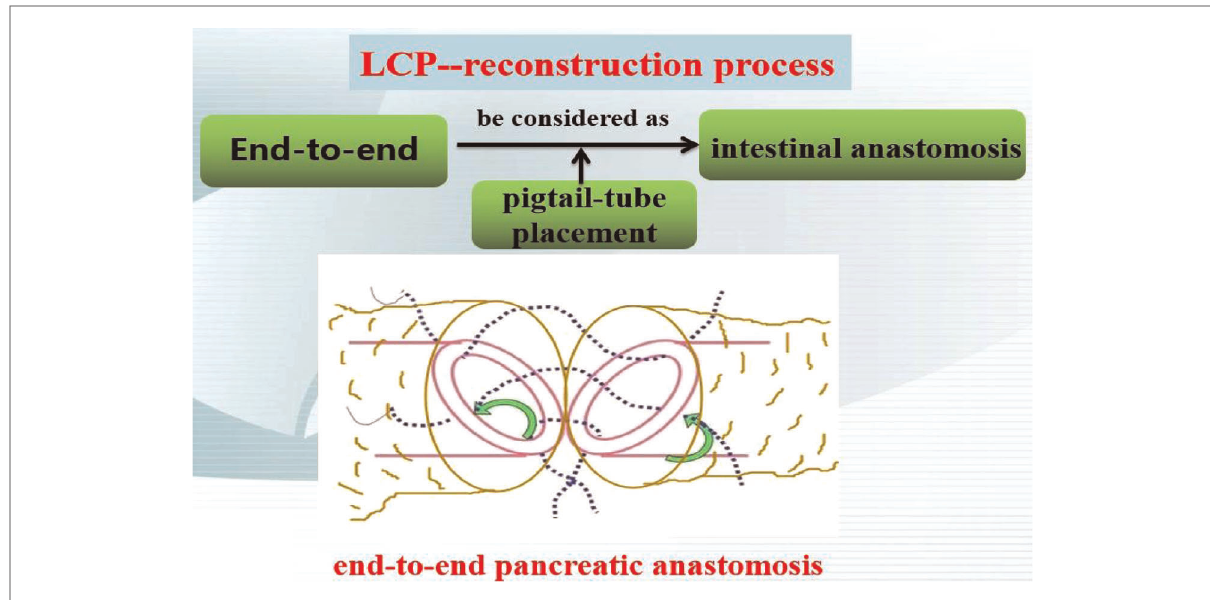
FIGURE 3 Pancreatic reconstruction process.